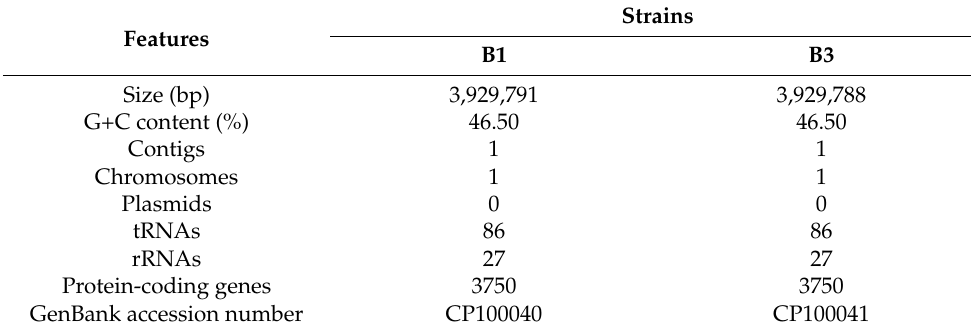
Table 5. Features of the B1 and B3